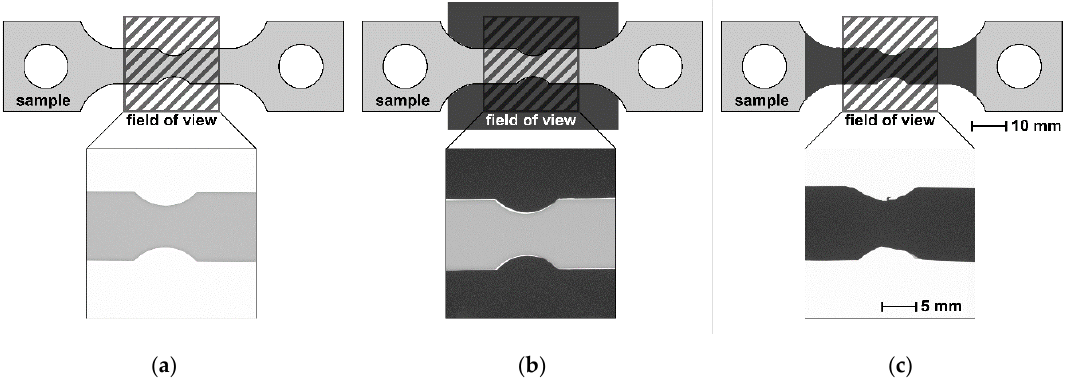
Figure 2. Scheme of measured flat bar tension samples and field of view of the radiographs (shaded square), which are displayed below the schemes. ( a ) Without Cd stencil, ( b ) with Cd stencil next to it (dark rectangle), ( c ) with Cd sheets (dark area) in front of sample.